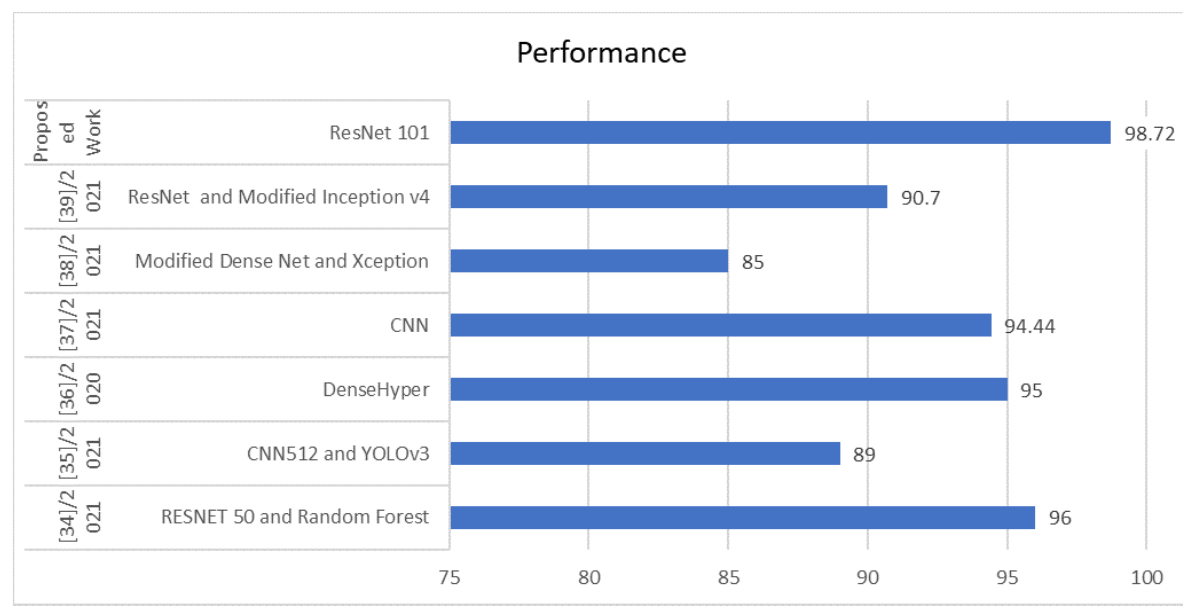
Figure 12. The Loss of Messidor and ODIR dataset.